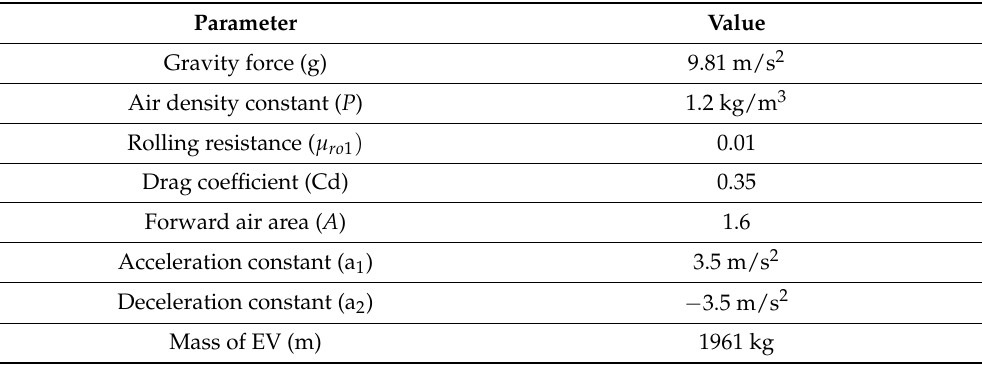
Table 2. Parameters of the EV in the